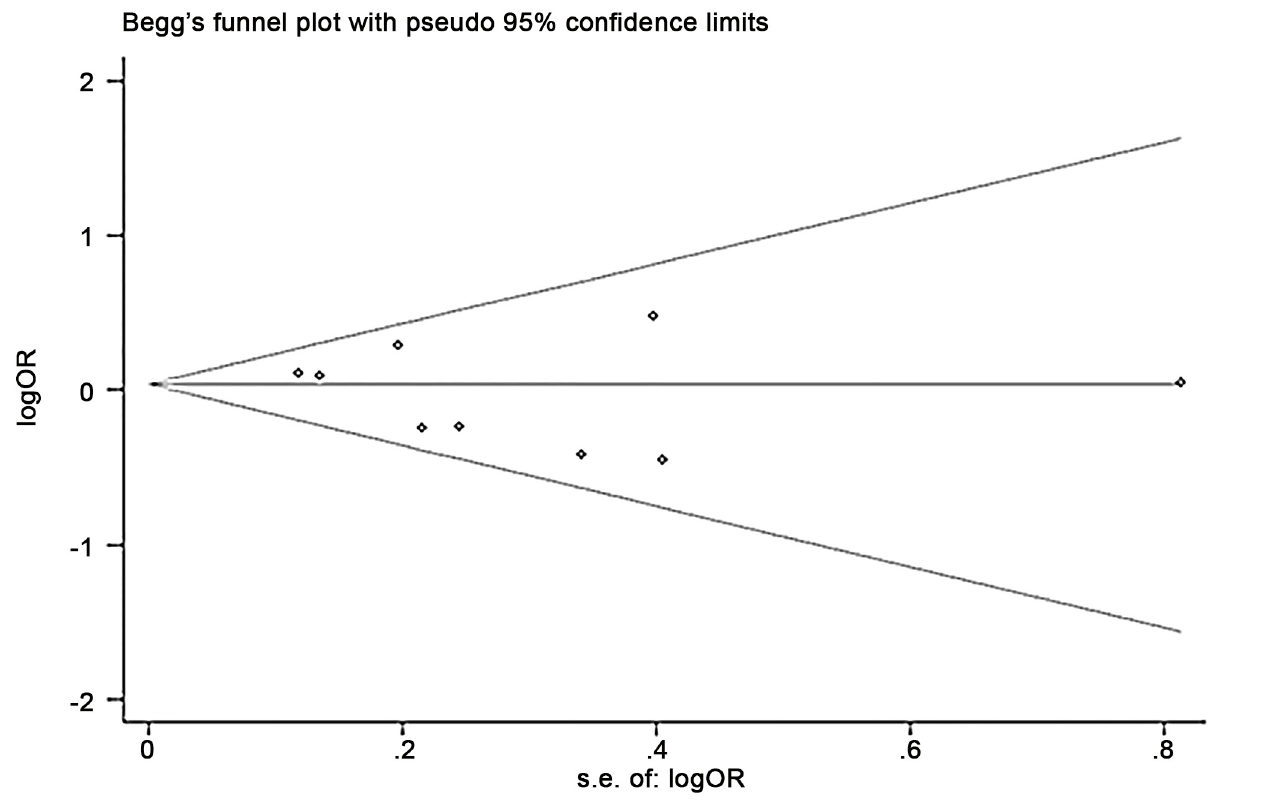
Fig 3. Begg ’ s funnel plot of all studies included in the meta-analysis for -857C > T polymorphism. Se: standard error.